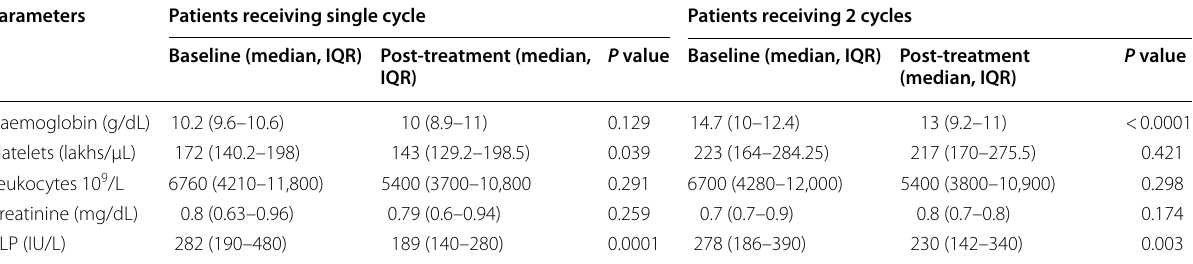
Table 6 Laboratory parameters at baseline and post-[ 177 Lu]Lu-DOTA-ZOL treatment Parameters